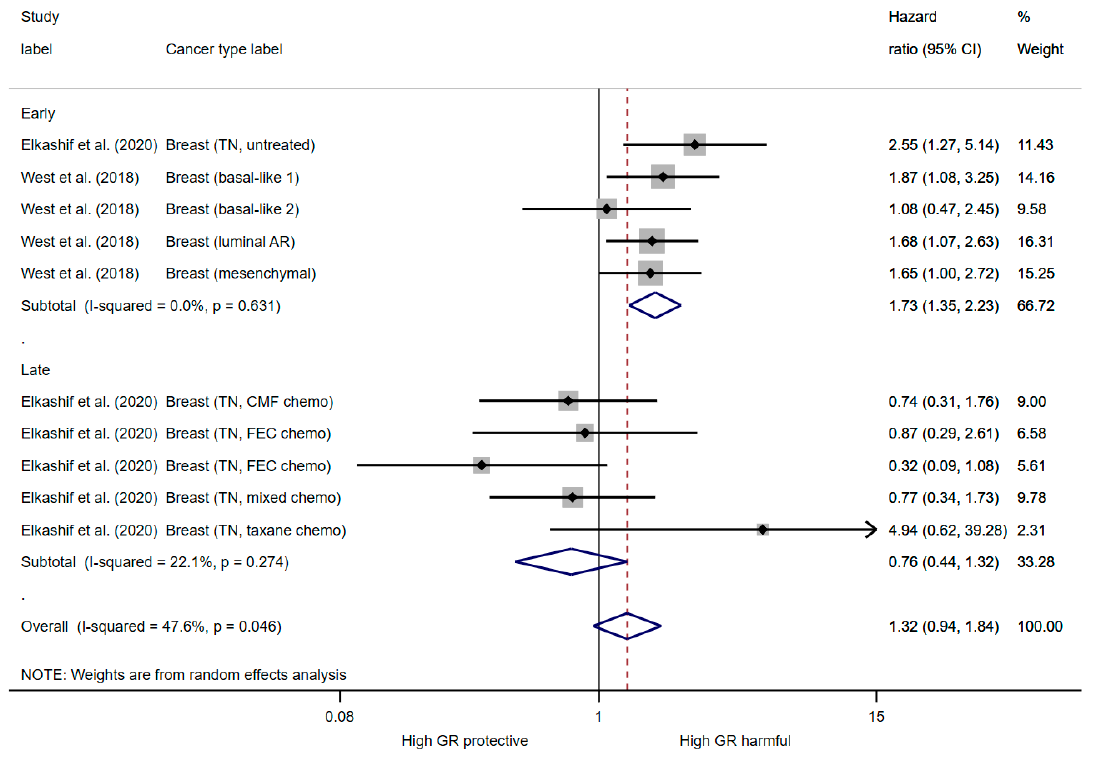
Figure 4. The forest plot for unadjusted progression free survival and glucocorticoid expression ( n = 3365). The meta analysis was preformed using hazard ratio and 95% confidence intervals (random effects). The chi-squared ( χ 2) for heterogeneity was performed and the proportion of variance between effect estimates is represented by I 2 , with a level of >50% considered significant.